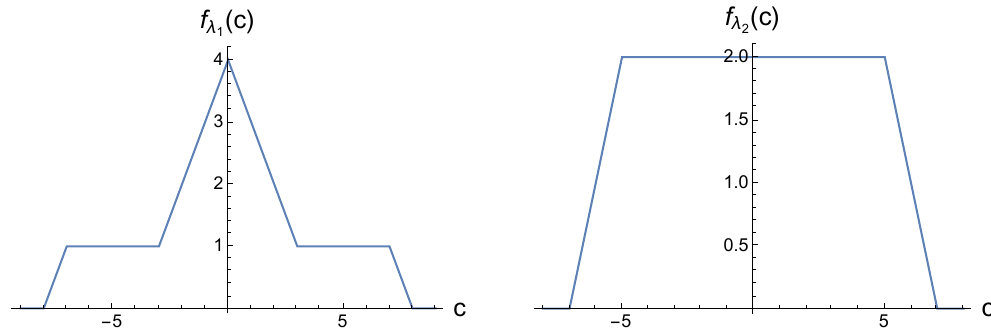
Figure 10 . The CDF plots for the partitions degenerate in